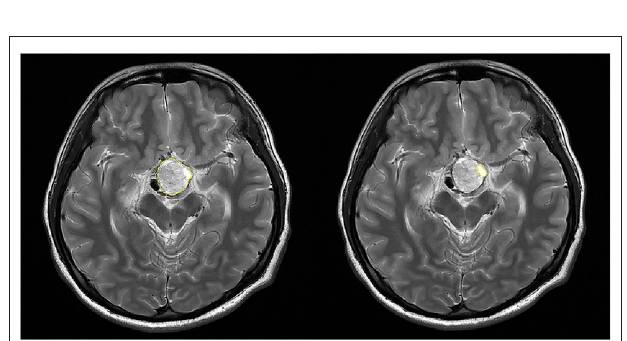
FIGURE 2 | Selection of the region of interest (ROI) in the calculation of volumes of the tumor and the hematoma. The tumor (Left) or the hematoma (Right) area on each slice of the DICOM image was recognized and circumscribed (yellow circle) with the software.